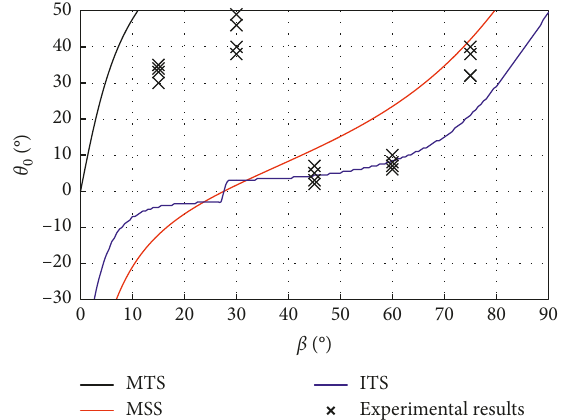
Figure 10: Comparison of initiation angles between theoretical and experimental